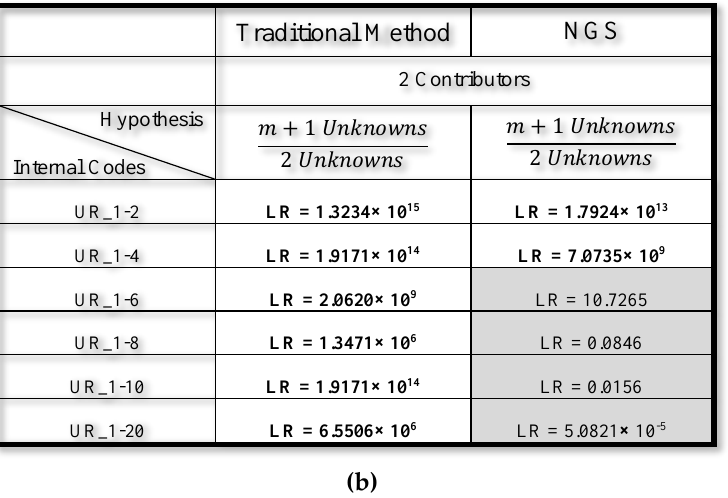
Figure 6. ( a ) Biostatistical and comparative analysis aimed at evaluating the inclusion or exclusion of the minor contributor (m) in the mixtures coming from buccal swab samples (semicontinuous method); ( b ) biostatistical and comparative analyses aimed at evaluating the inclusion or exclusion of the minor contributor (m) in the mixtures coming from urine samples (semicontinuous method).